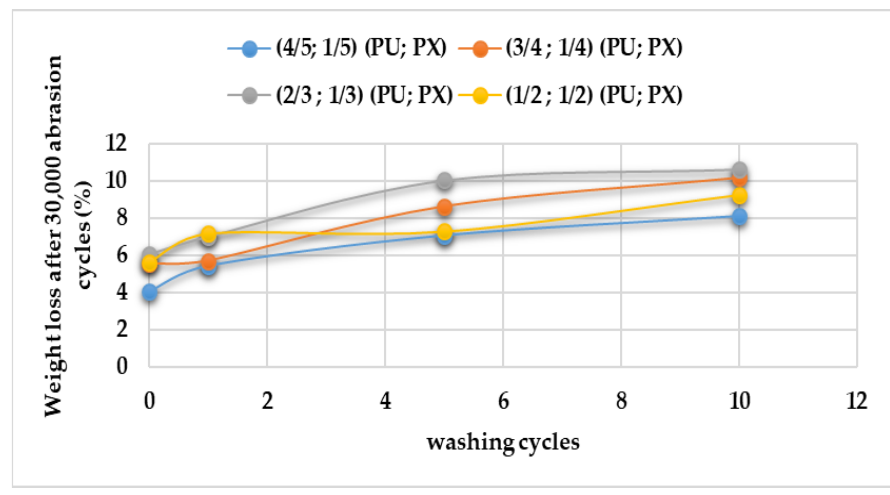
Figure 11. Mass loss rate of fabric, treated with the four different polymer blend combinations (PU;PX), measured after zero, one, five, and ten wash cycles, with 30,000 abrasion cycles for each.